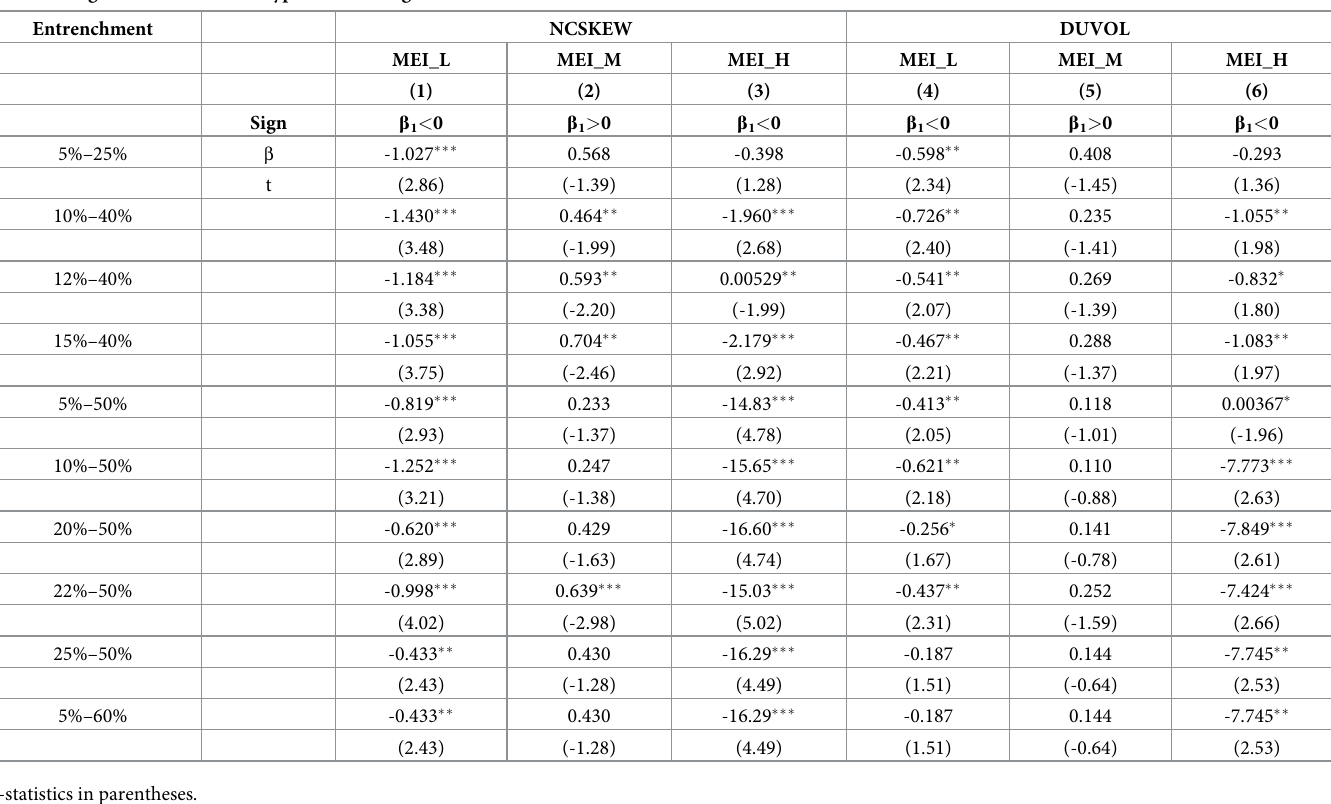
Table 4. Regressions for further hypothesis